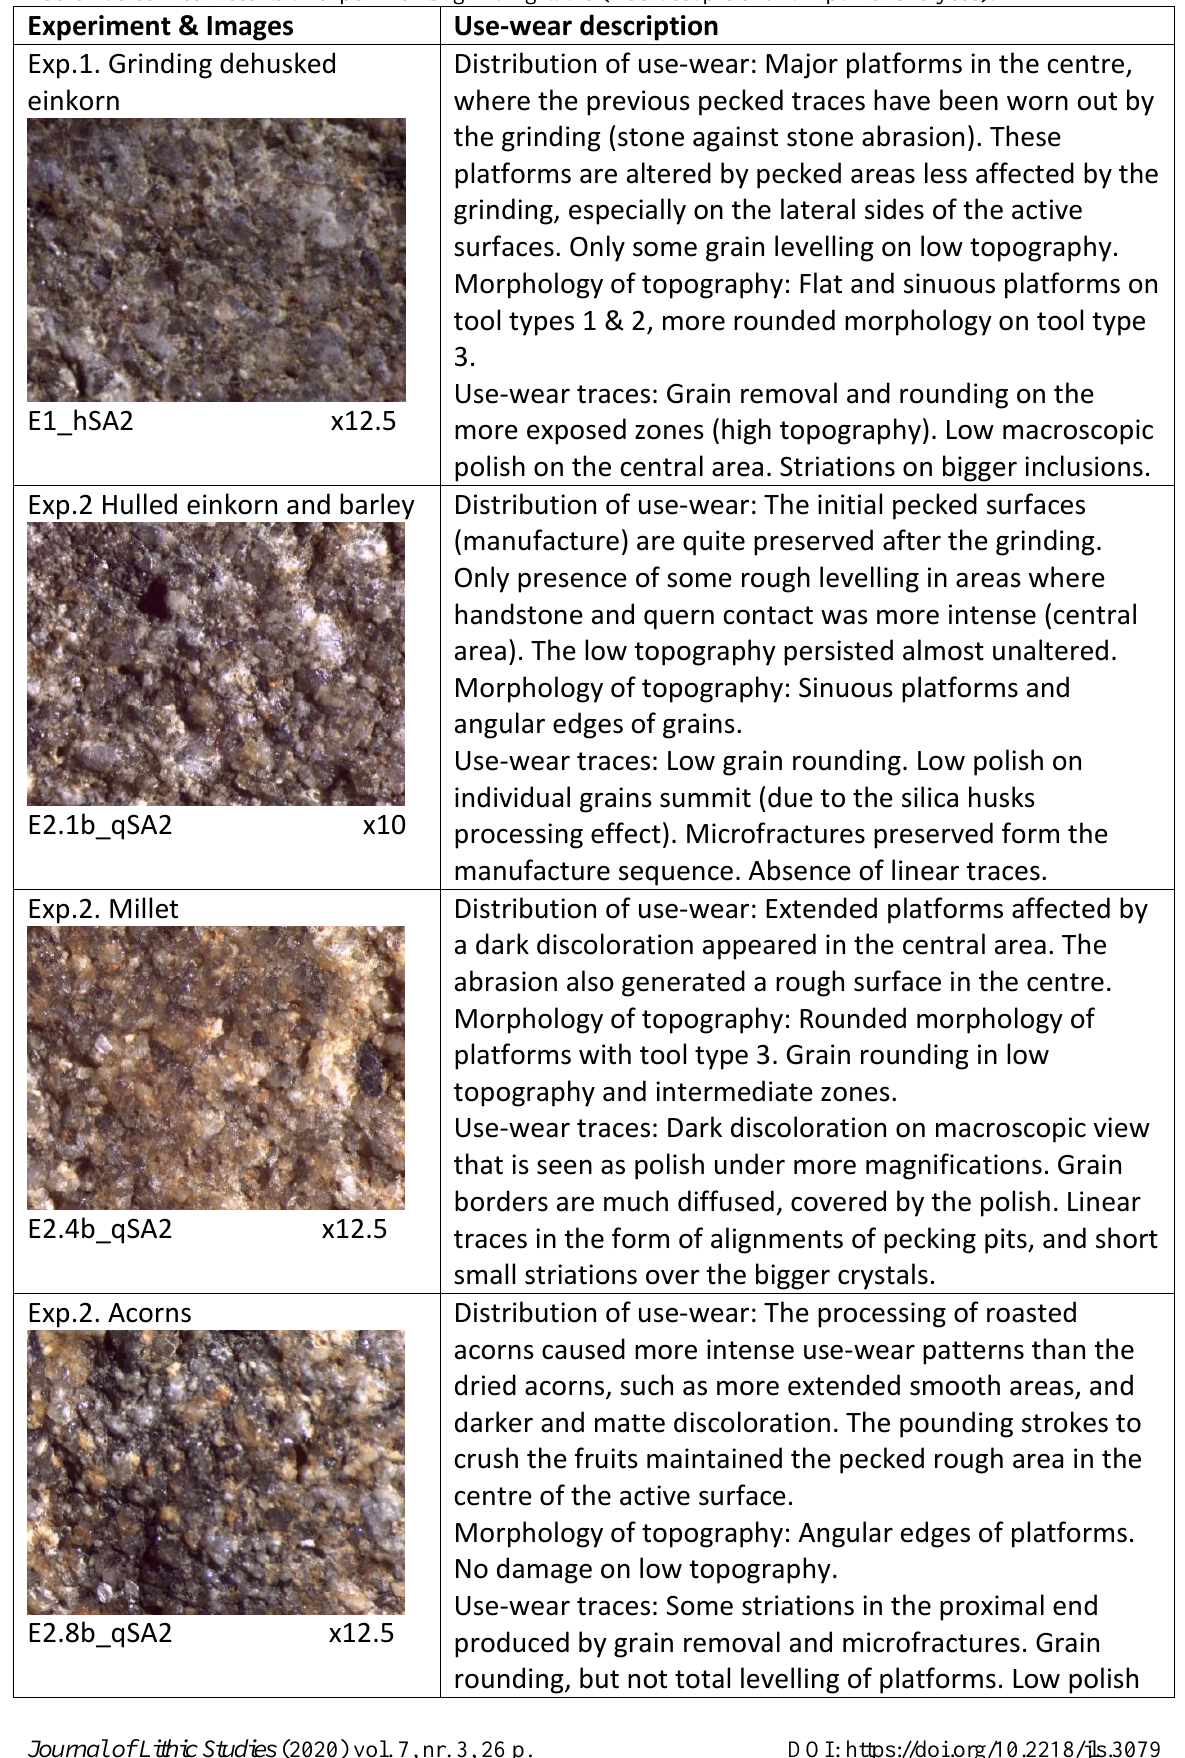
Table 4. Use-wear results of experimental grinding tools (macroscopic and low power analyses). Experiment &